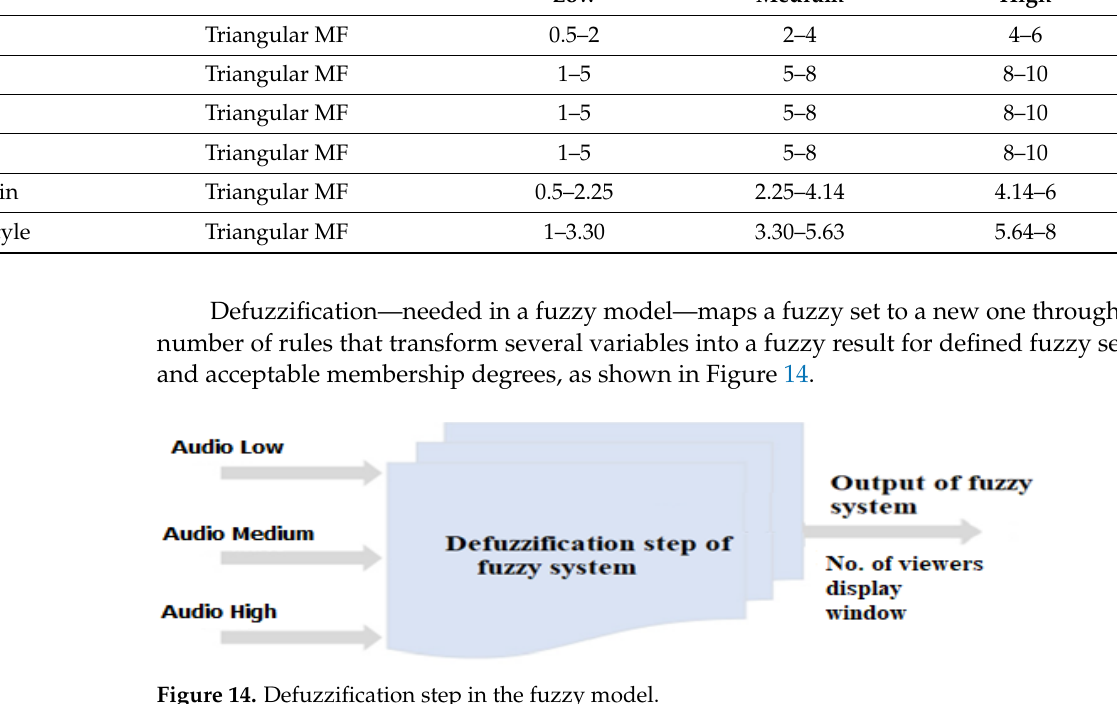
Figure 14. Defuzzification step in the fuzzy model.